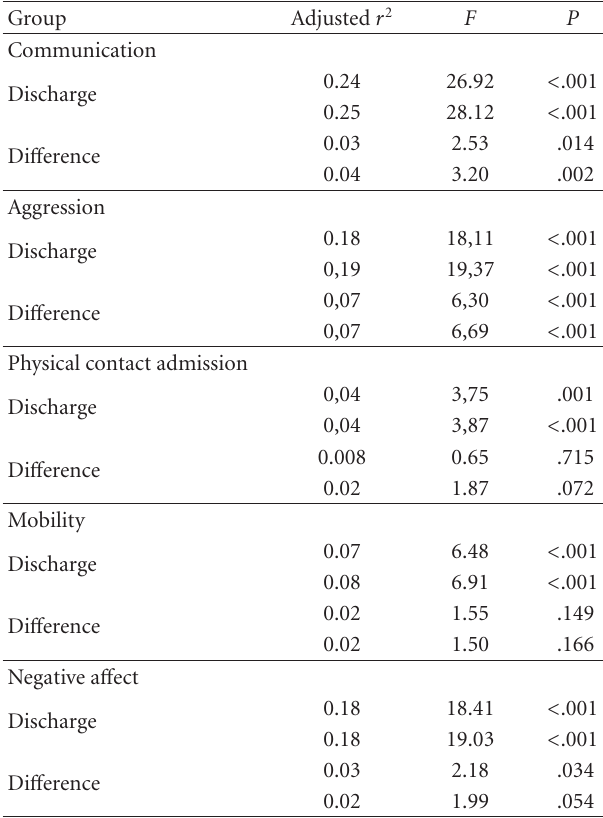
Table 5: Multivariate regression analysis with QoL variables and their changes as dependent and personality (interview-data—1st row; visual analogue scale—2nd row) as